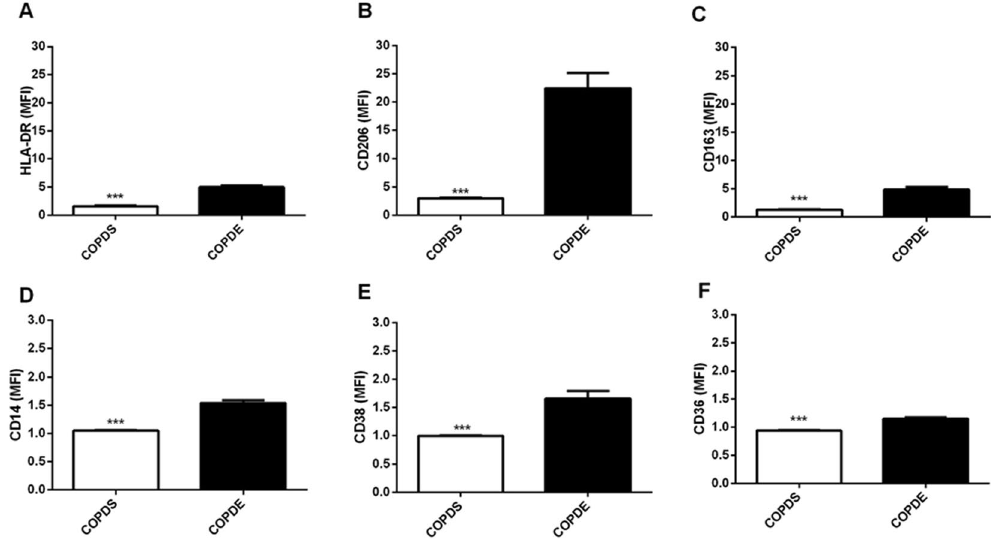
Figure 4. The expression of macrophage markers in the large alveolar macrophage population in COPD (including smoking status). Flow cytometric analysis of large alveolar macrophages for n = 7 COPD smokers (COPDS) and n = 6 COPD ex-smokers (COPDE). Markers analysed were HLA-DR ( A ), CD206 ( B ), CD163 ( C ), CD14 ( D ), CD38 ( E ) and CD36 ( F ). Data is expressed as the median fluorescence intensity (MFI) of each marker and represents mean (SEM). Unpaired t test (Two-tailed) was performed for each marker. *** Significantly different compared to expression of the same marker on large alveolar macrophages from COPDE patients (p <